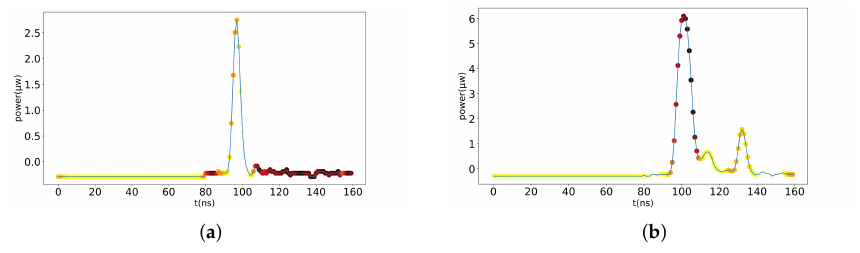
Figure 12. 1D FCN-LSTM feature visualization.